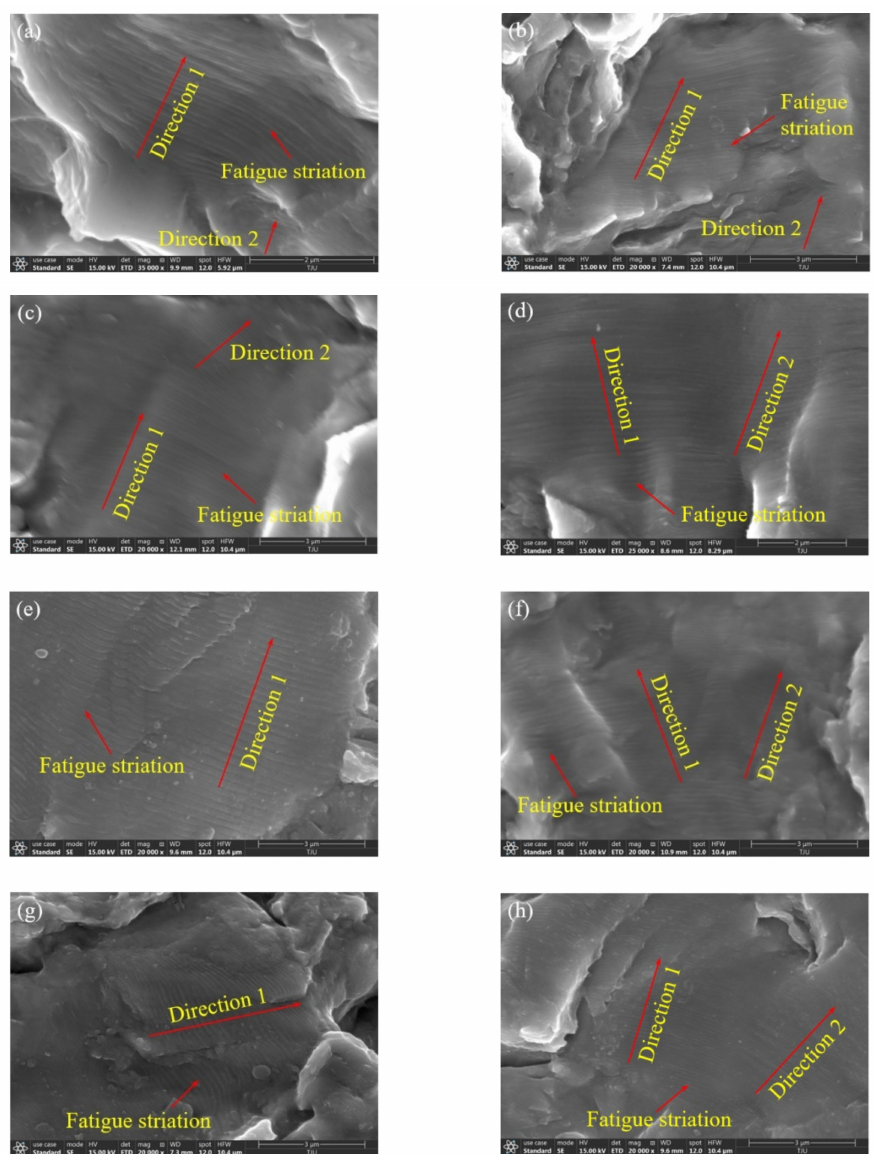
Figure 9. SEM morphology of fatigue crack stable propagation zone. ( a ) Equiaxed I, σ a = 330 MPa, N f = 1.26 × 10 6 ; ( b ) equiaxed I, σ a = 218 MPa, N f = 6.06 × 10 8 ; ( c ) equiaxed II, σ a = 300 MPa, N f = 4.25 × 10 6 ; ( d ) equiaxed II, σ a = 233 MPa, N f = 3.16 × 10 8 ; ( e ) bimodal I, σ a = 285 MPa, N f = 5.08 × 10 6 ; ( f ) bimodal I, σ a = 225 MPa, N f = 4.15 × 10 8 ; ( g ) bimodal II, σ a = 270 MPa, N f = 6.39 × 10 6 ; ( h ) bimodal II, σ a = 233 MPa, N f = 3.25 × 10 8